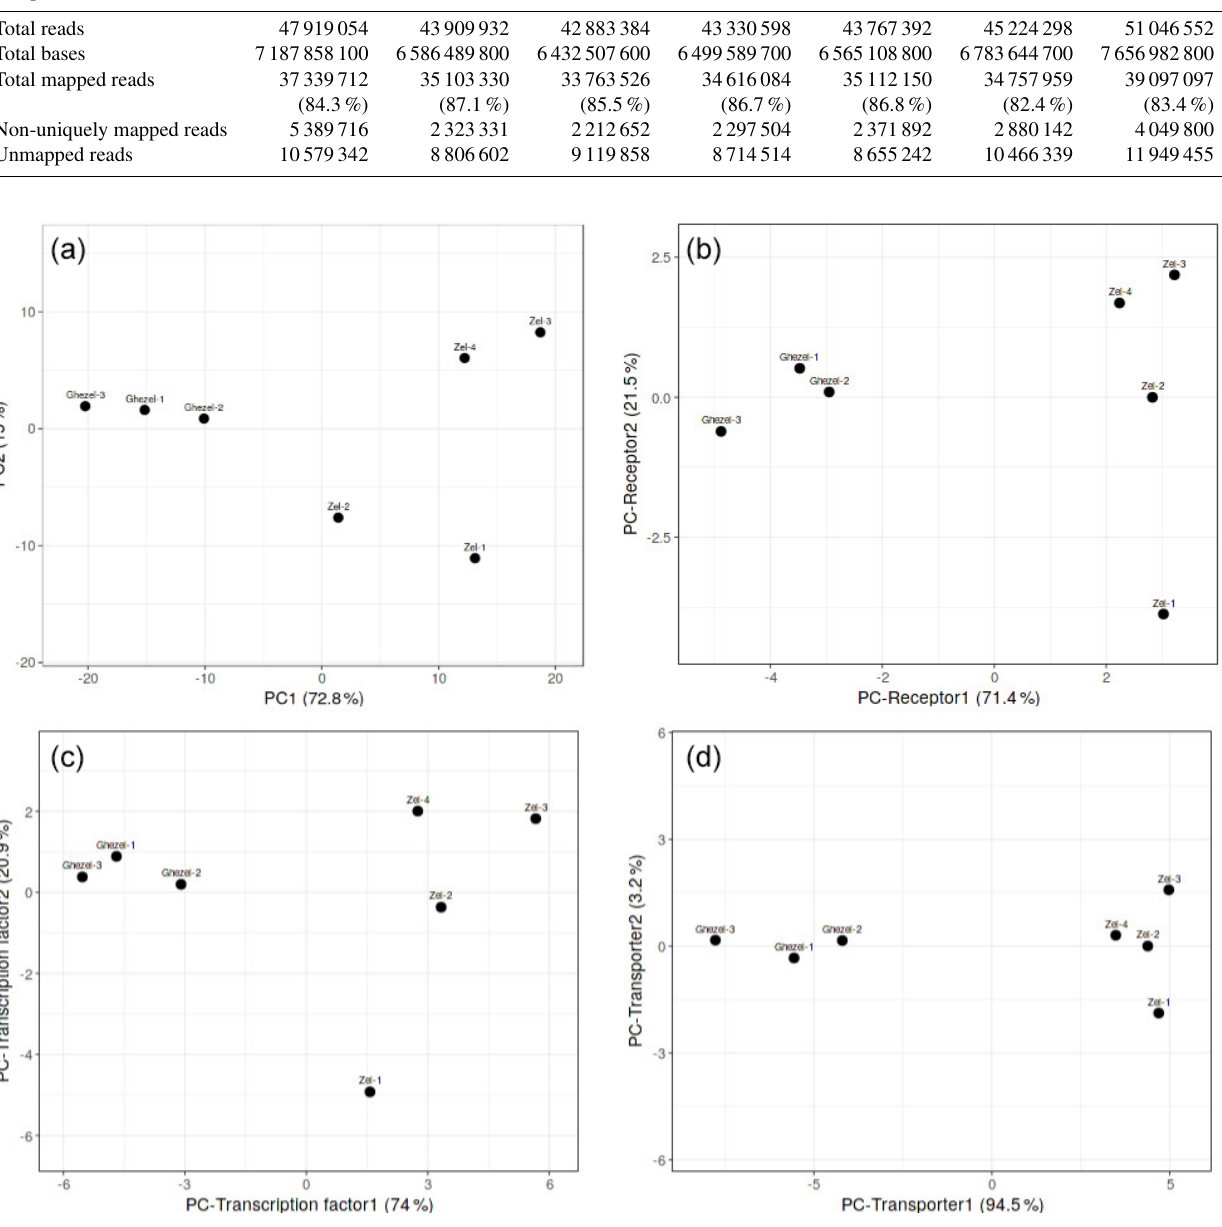
Figure 1. PCA scatter plot of differentially expressed genes in adipose tissues between Zel (thin-tailed) and Ghezel (fat-tailed) sheep breeds: (a) total differentially expressed genes, (b) differentially expressed receptors, (c) differentially expressed transcription factors, (d) differen- tially expressed